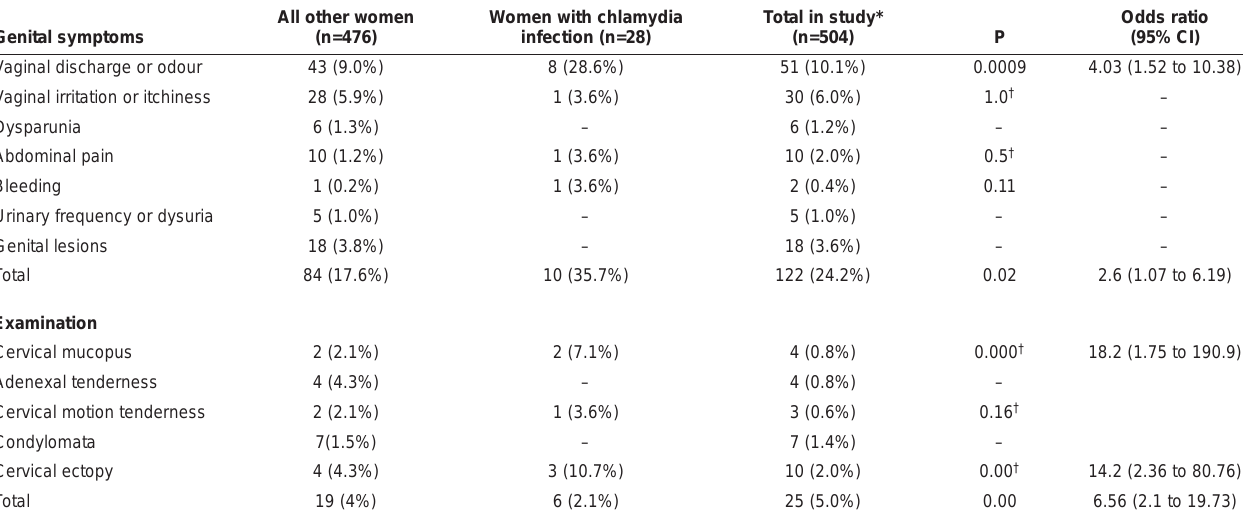
TABLE 1 Clinical symptoms reported by women with and without chlamydia infection* All other women Women with